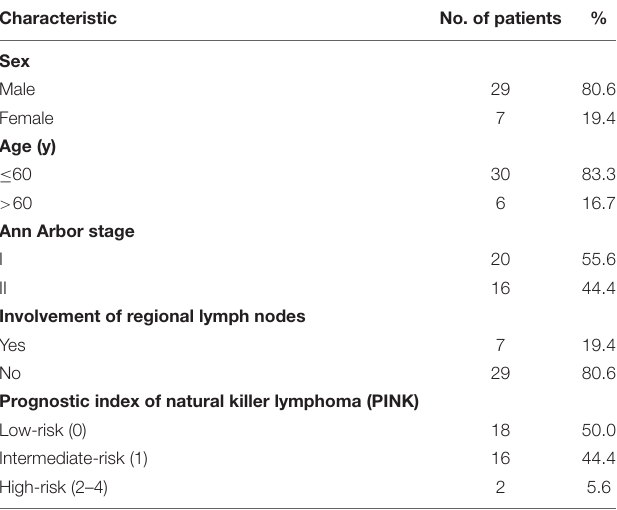
TABLE 1 | Clinical characteristics of the patients in Cohort A ( n = 36).